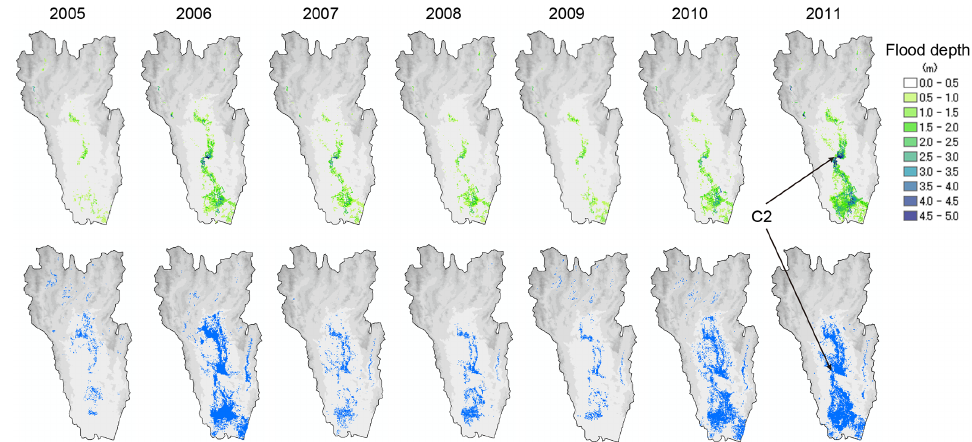
Figure 4. Simulated (upper panel) and remotely sensed (lower panel) annual maximum flood inundation extents from 2005 to 2011. The source of the remote sensed extents is GISTDA for 2005–2010 and UNOSAT for